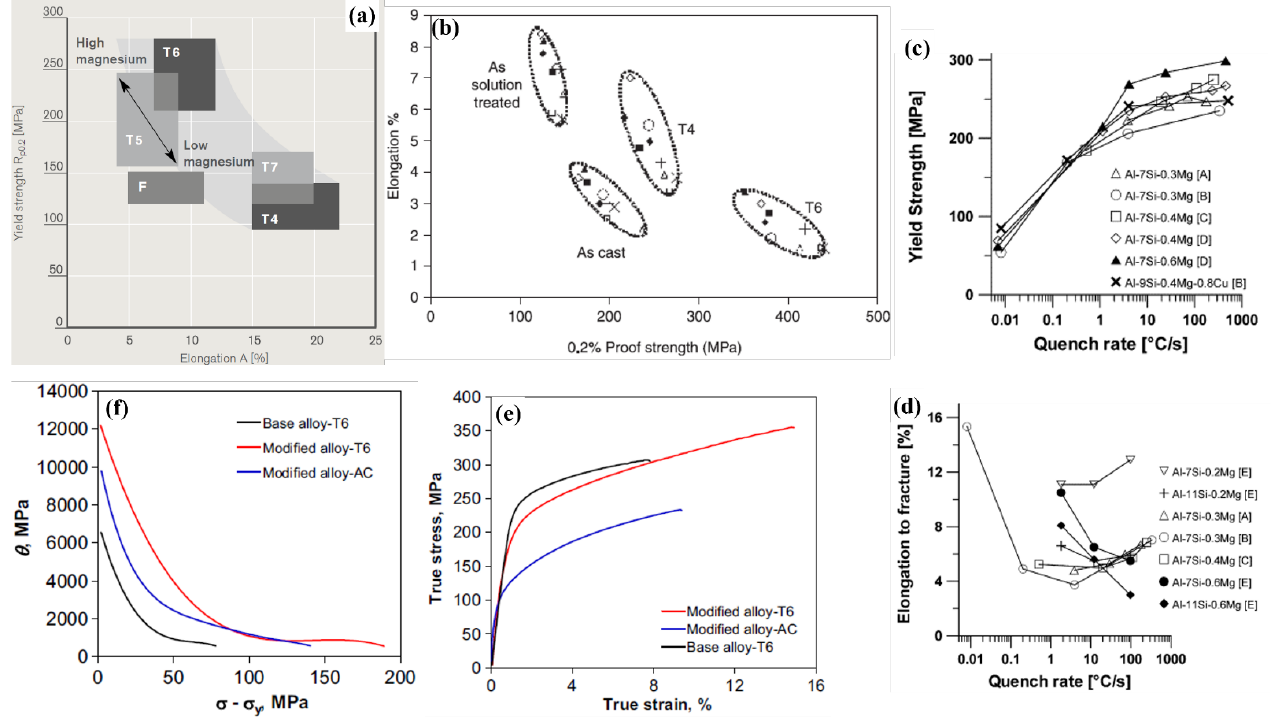
Figure 9. ( a ) YS vs. elongation for various heat-treatment states and Mg content for Silafont ® -36 alloys [40]. ( b ) Elongation vs. YS for the as-cast, as-solution-treated, T4, and T6 tempers for HPDC Al-Si-Cu alloys [78]. Effect of quench rate on ( c ) YS and ( d ) elongation to fracture as functions of quench rate for various Al-7%Si-Mg alloys [227]. ( e ) True stress–strain curves and ( f ) work-hardening rate plot or Kocks – Mecking (K-M) plot for the base and modified Al-Si-Cu-Mg alloys under tensile loading [230]. Reproduced with permission from Elsevier.